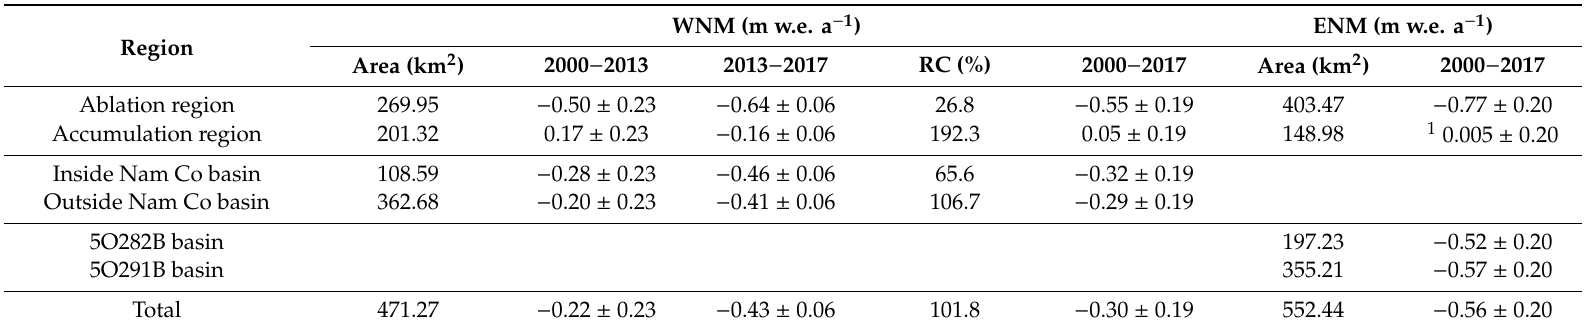
Table 6. Area and mass balance (unit: m w.e. a − 1 ) of glaciers in the WNM and ENM from 2000 to 2017. The Relative Change (RC) represents glacier relative change. Yanong glacier was excluded when calculating region-wide glacier mass balance in the ENM because of incomplete coverage by our